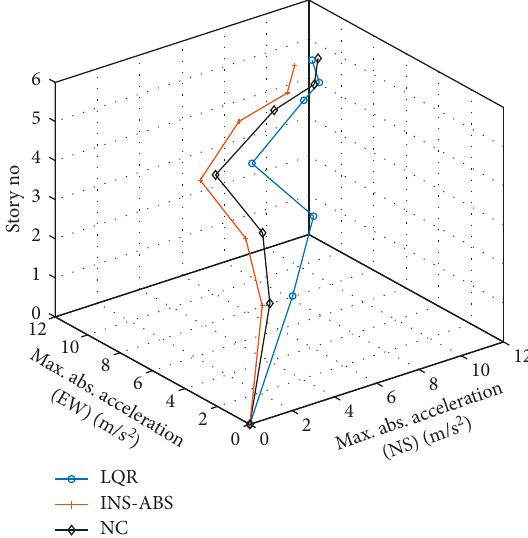
Figure 9: Maximum absolute accelerations in N-S and E-W di- rections for Erzincan bidirectional ground